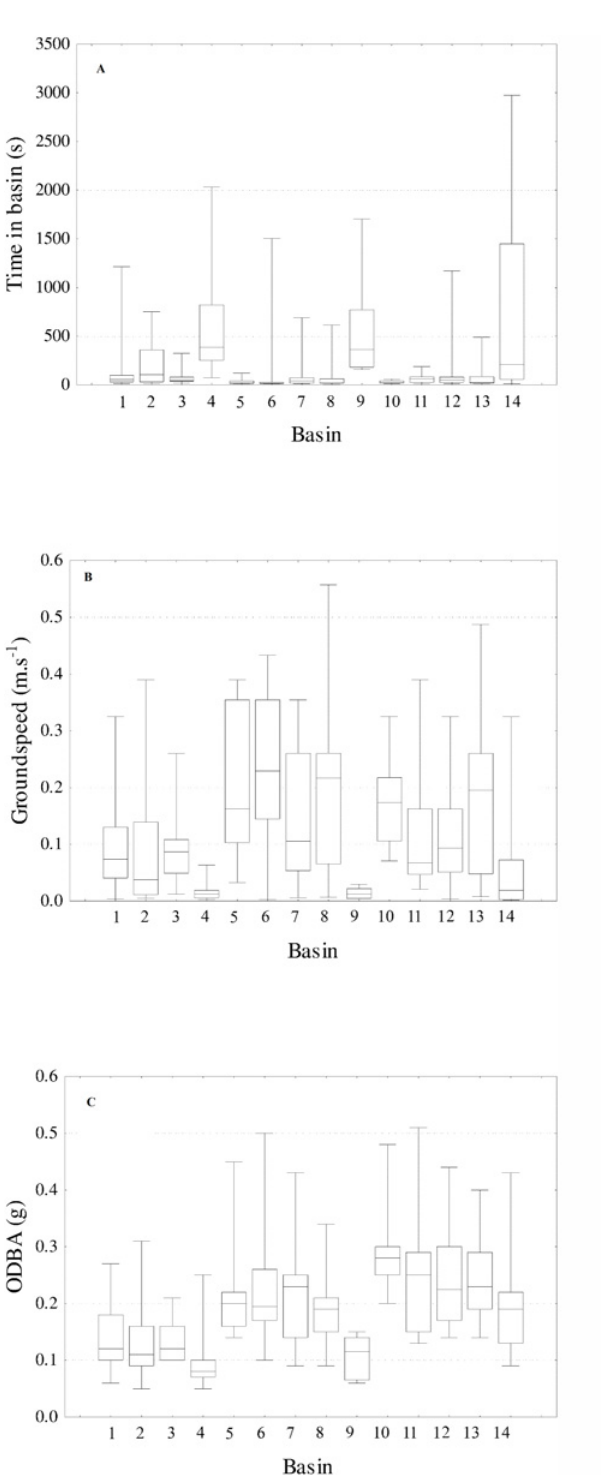
Fig 2. Box plots with the median (horizontal lines), interquartile ranges (boxes), and ranges (whiskers) of the time spent in each basin (A), groundspeed (B) and ODBA (C) exhibited by silver redhorse